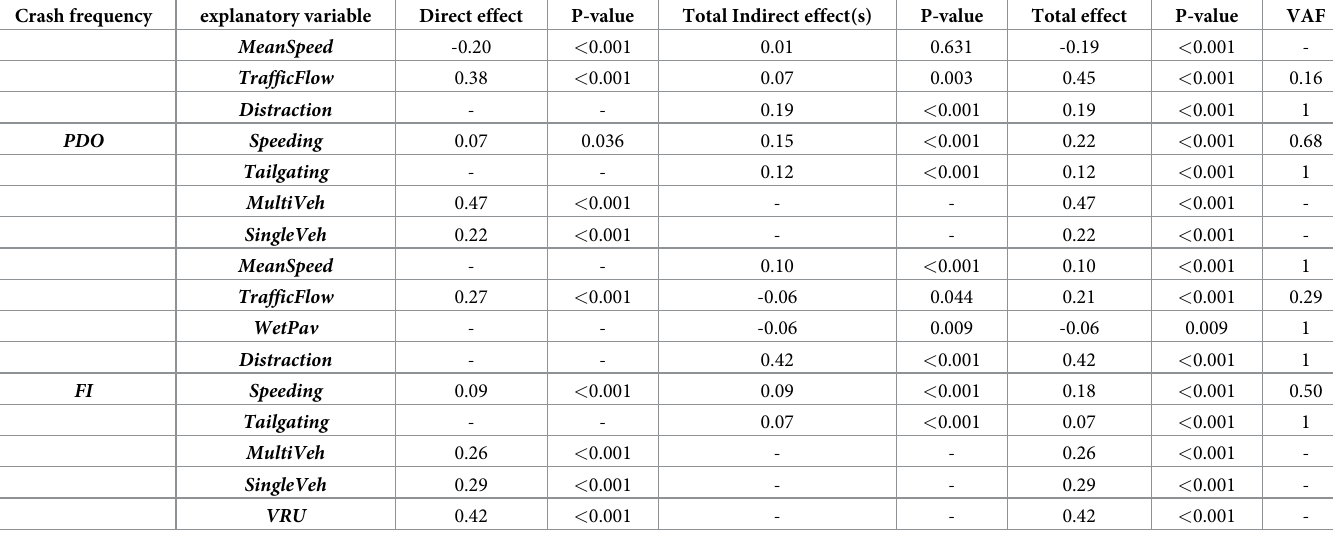
Table 5. Direct, indirect, and total effects of explanatory variables on crash frequency by